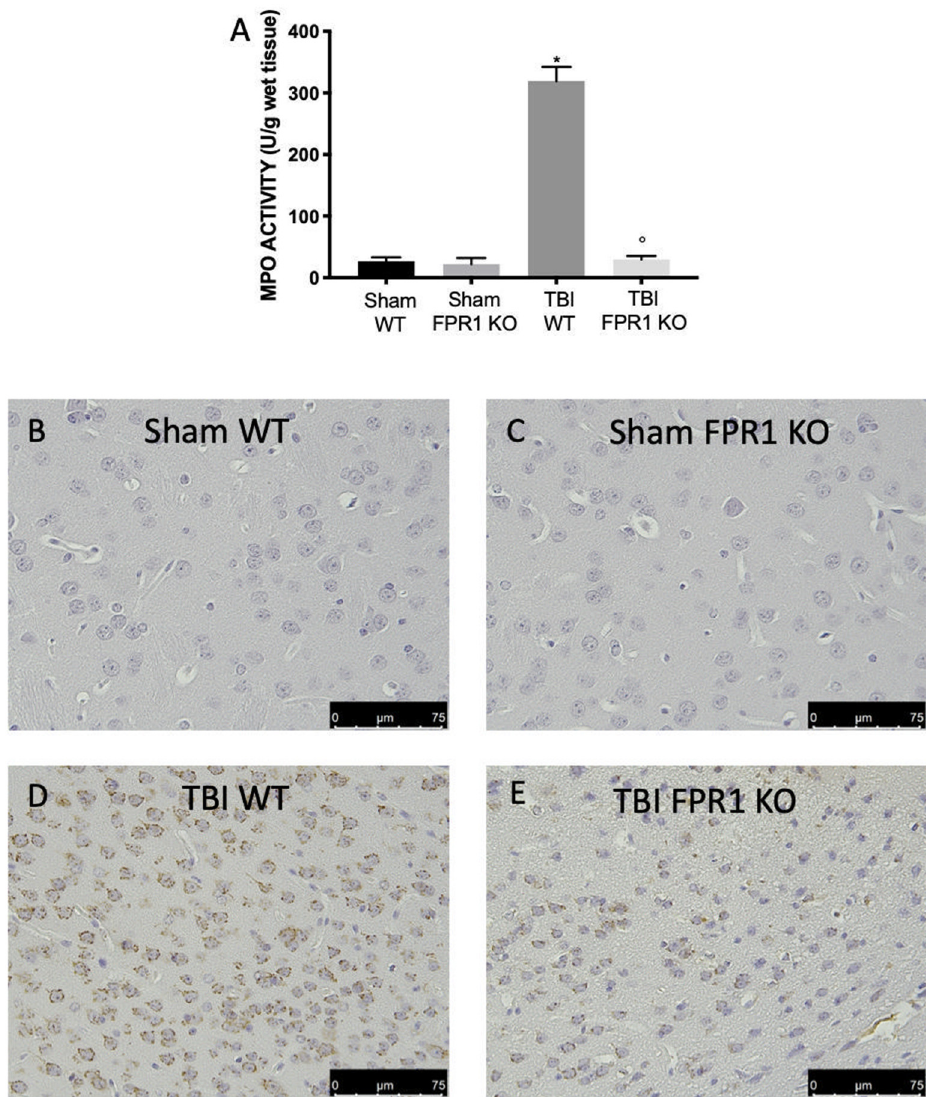
Figure 2. Effect of the absence of Fpr1 on neutrophils accumulation: TBI Fpr1 KO mice showed a reduction in brain MPO activity ( A ) Immunohistochemical analysis showed an increased number of MPO-positive cells in WT animals subjected to TBI 24 h after injury ( D ) compared to the Sham WT group ( B ) and Sham Fpr1 KO group ( C ). Fpr1 KO animals 24 h after TBI shows significantly less MPO-positive cells ( E ). For the analyses, n = 5 animals from each group were employed. Results were analyzed by two-way ANOVA followed by a Bonferroni post-hoc test for multiple comparisons. Non-parametric data were analyzed with Fisher’s exact test. * p < 0.05 vs. Sham WT; ° p < 0.05 vs. TBI WT. scale bar 75 µm.